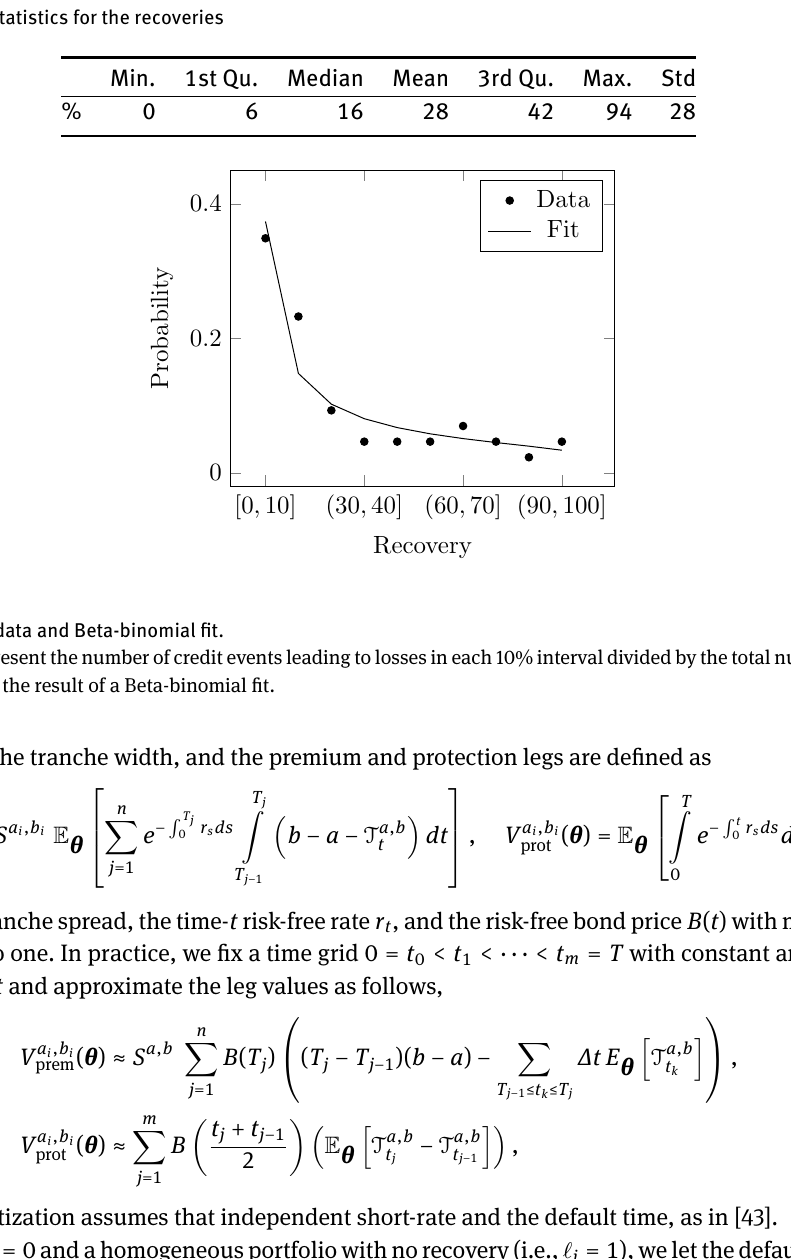
Table 2: Summary statistics for the recoveries